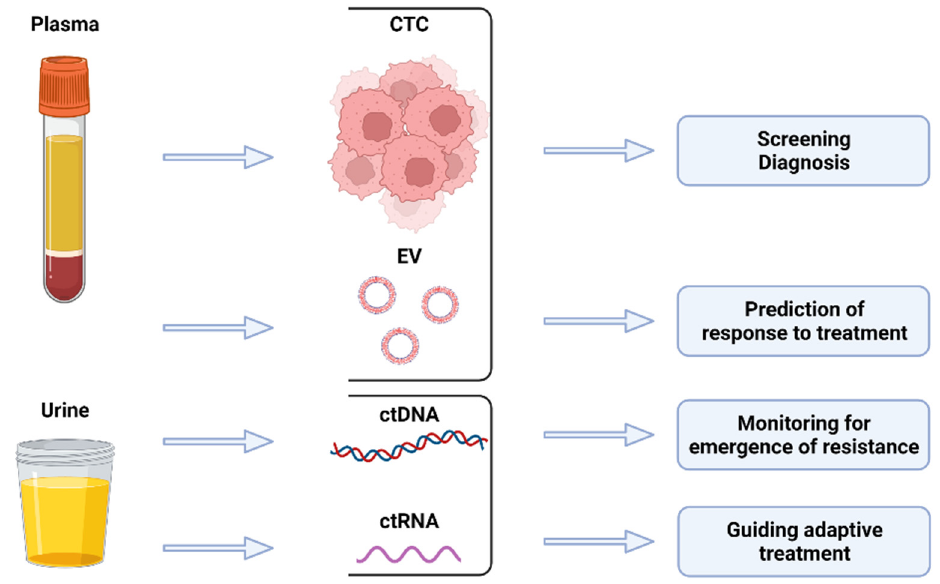
Figure 1. Liquid biopsy analytes and their potential applications.